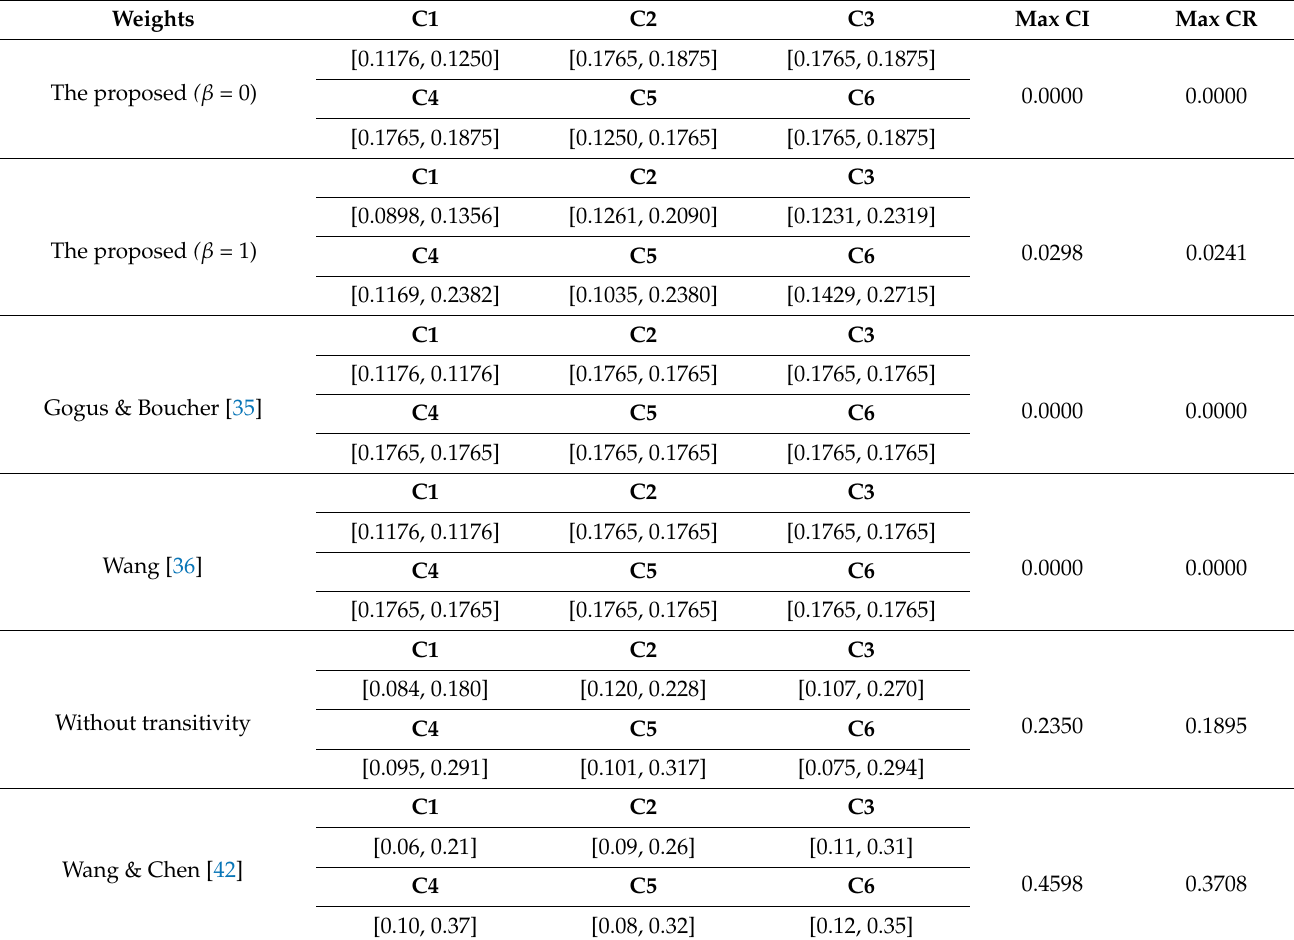
Table 5. Different FAHP results in Example